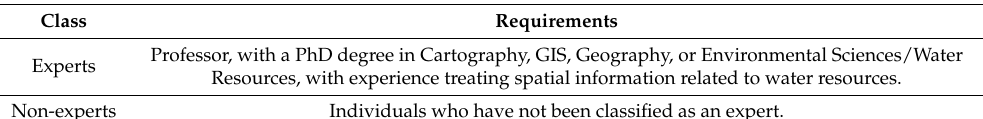
Table 1. Definition of the users’ profile.